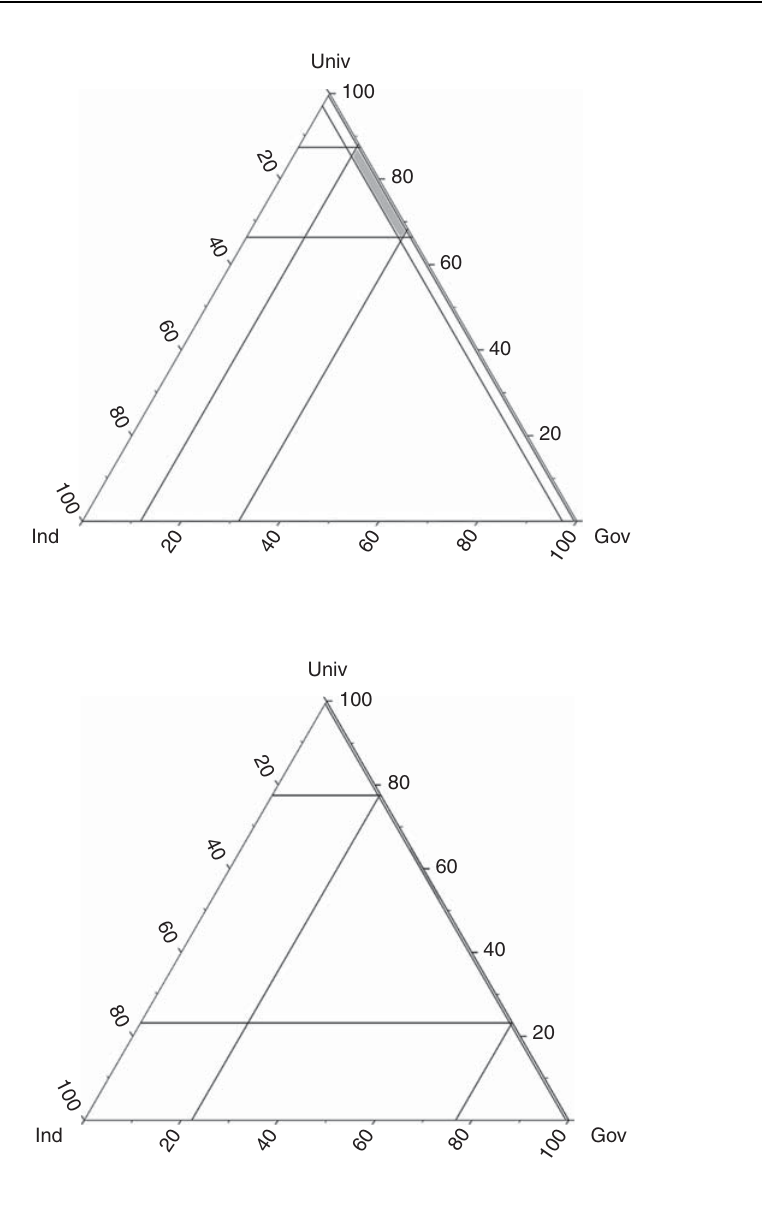
Figure 5. Core of Burkina